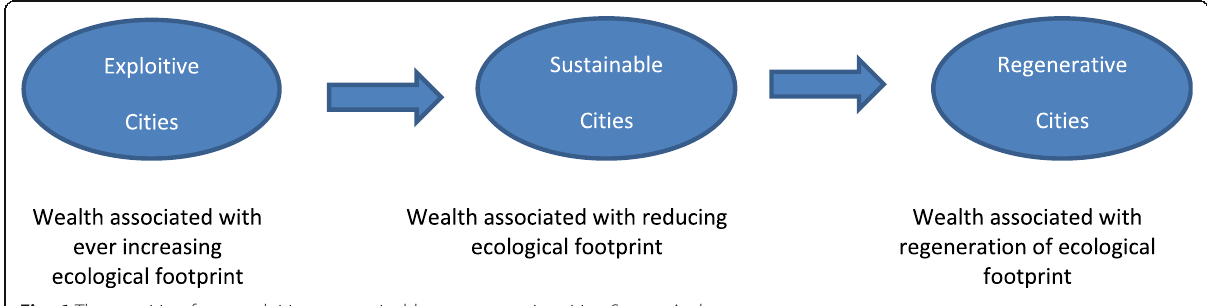
Fig. 6 The transition from exploitive to sustainable to regenerative cities. Source Author